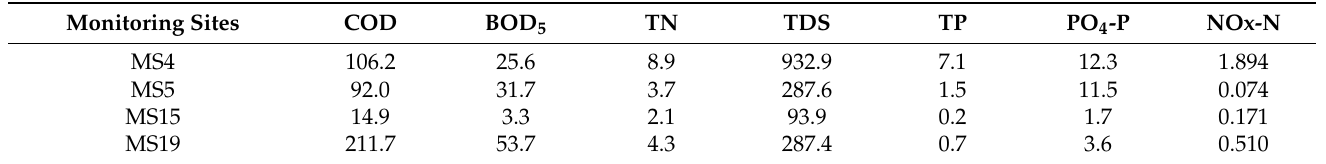
Table 11. Point source (PS) loads of selected physicochemical parameters using FLUX 32 in Hawassa City,